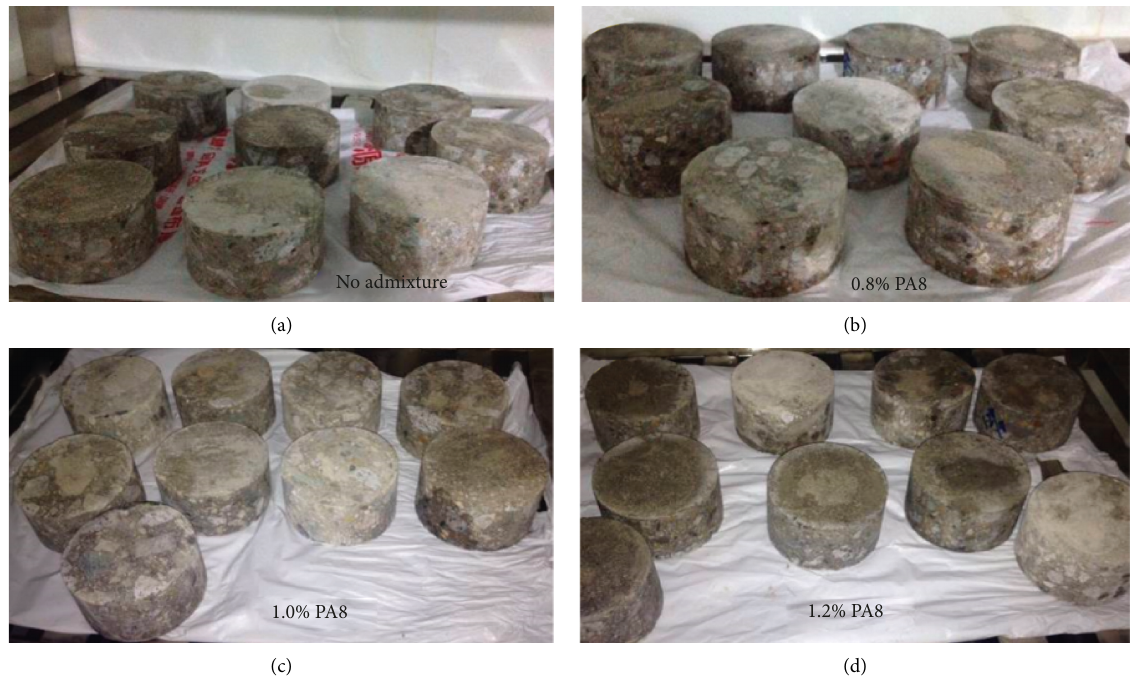
Figure 3: Standard concrete samples with different PA8 contents: (a) plain concrete samples, (b) optimized concrete samples with 0.8% PA8 content, (c) optimized concrete samples with 1.0% PA8 content, and (d) optimized concrete samples with 1.2% PA8